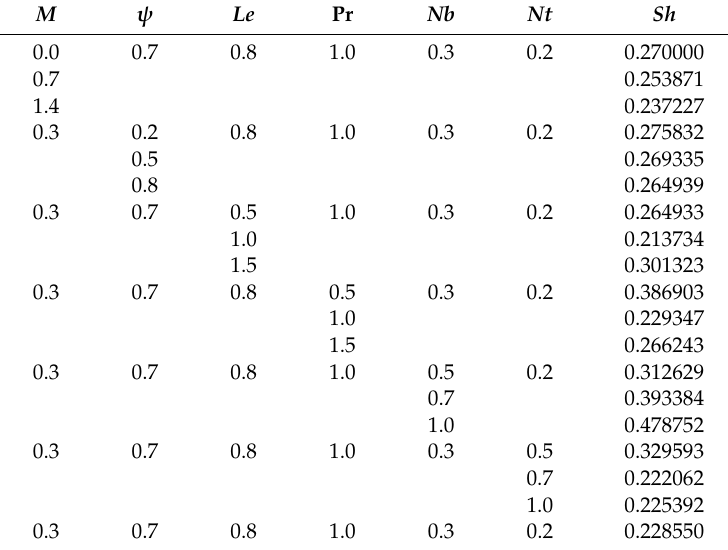
Table 3. Results of Sh against M , ψ , Le , Pr, Nb , and Nt